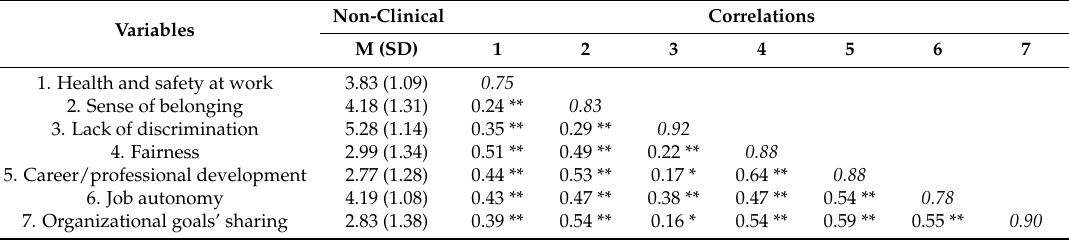
Table 3. Means, standard deviations, and correlations for the non-clinical staff sample.